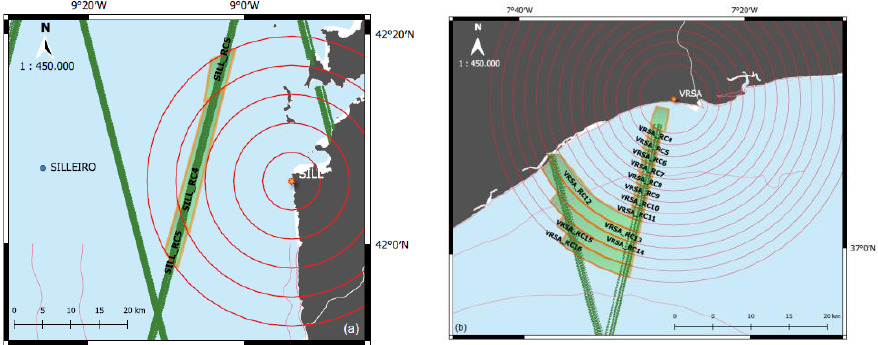
Figure 6. Sentinel-3 tracks over HFR RC. Exemplificative schema for ( a ) SILL HFR and ( b ) VRSA HFR. Green tracks: Sentinel-3 tracks with SRAL measurements; red circles: RC; blue dot: Silleiro buoy.